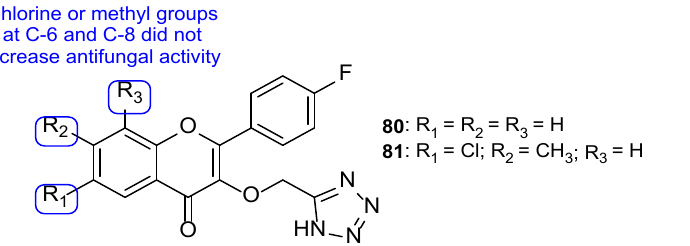
Figure 40. Chemical structures for compounds 80 and 81 , and SAR regarding the phenyl ring [120].